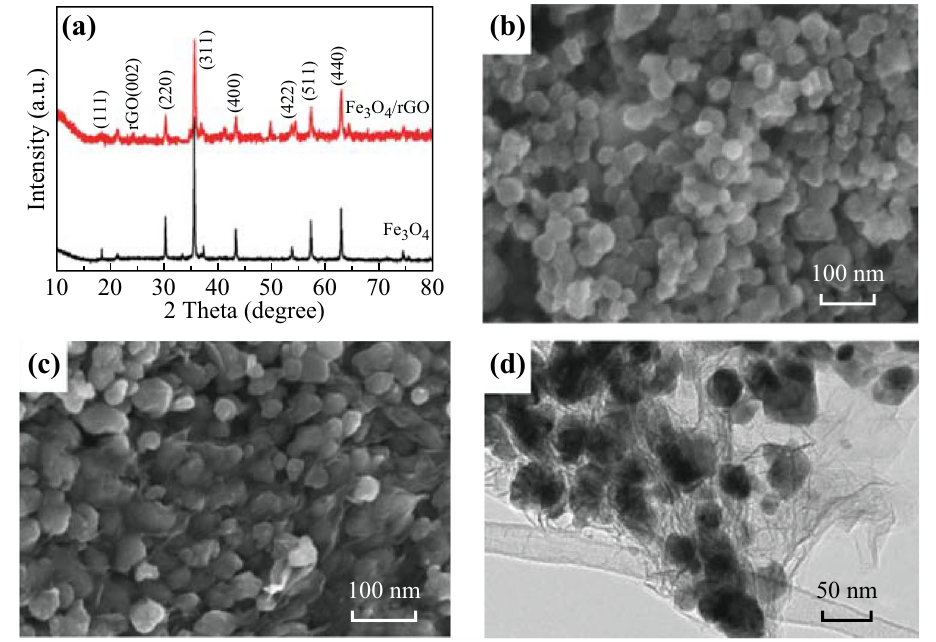
Fig. 1 a XRD patterns of the as-prepared Fe 3 O 4 and Fe 3 O 4 /rGO precursors, b SEM image of Fe 3 O 4 , c SEM image, and d TEM image of Fe 3 O 4 /